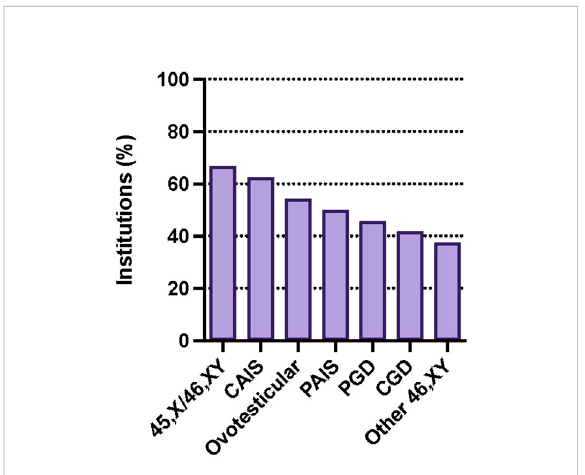
FIGURE 4 Percentage of institutions offering GTC by diagnosis: 45,X/46,XY DSD (66.7%), CAIS (62.5%), ovotesticular DSD (54.2%), PAIS (50%), partial gonadal dysgenesis (PGD) (45.8%), complete gonadal dysgenesis (CGD) (41.7%). Survey participants could choose more than one